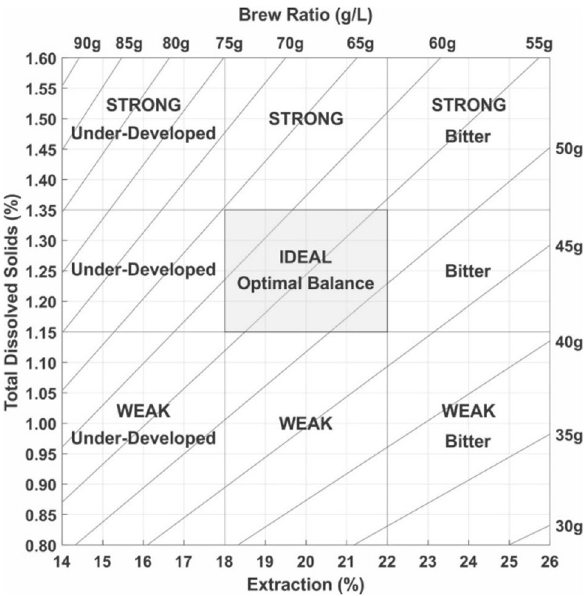
Figure 1. The classic Coffee Brewing Control Chart, originally developed by Lockhart 2 . Reproduced from Lingle 4